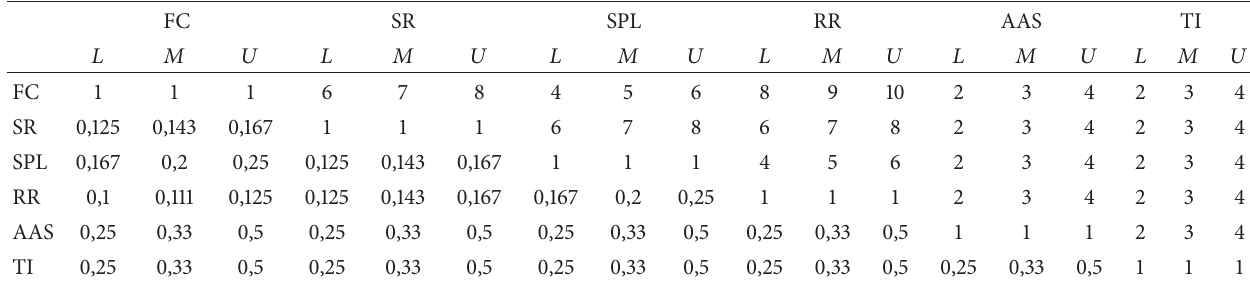
Table 5: Pairwise comparison for 𝑊 21 .